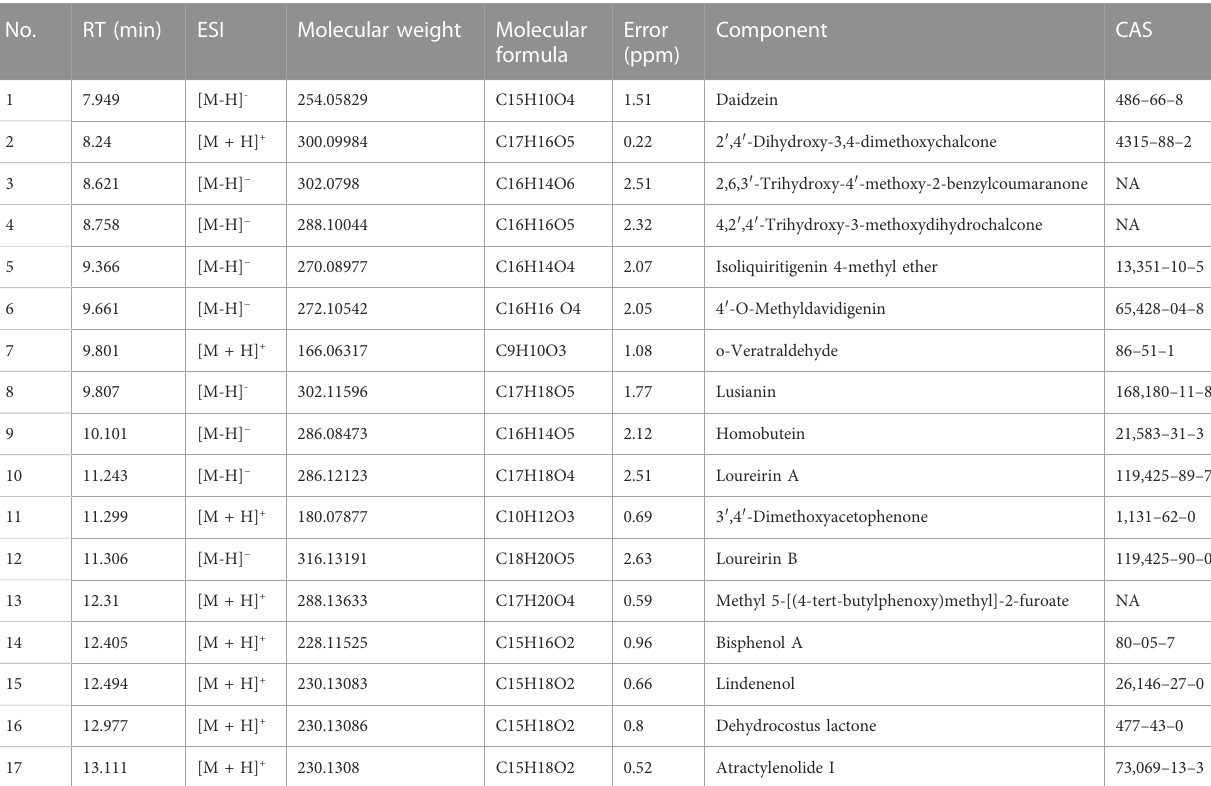
TABLE 4 Identi fi ed chemical components of XJS.